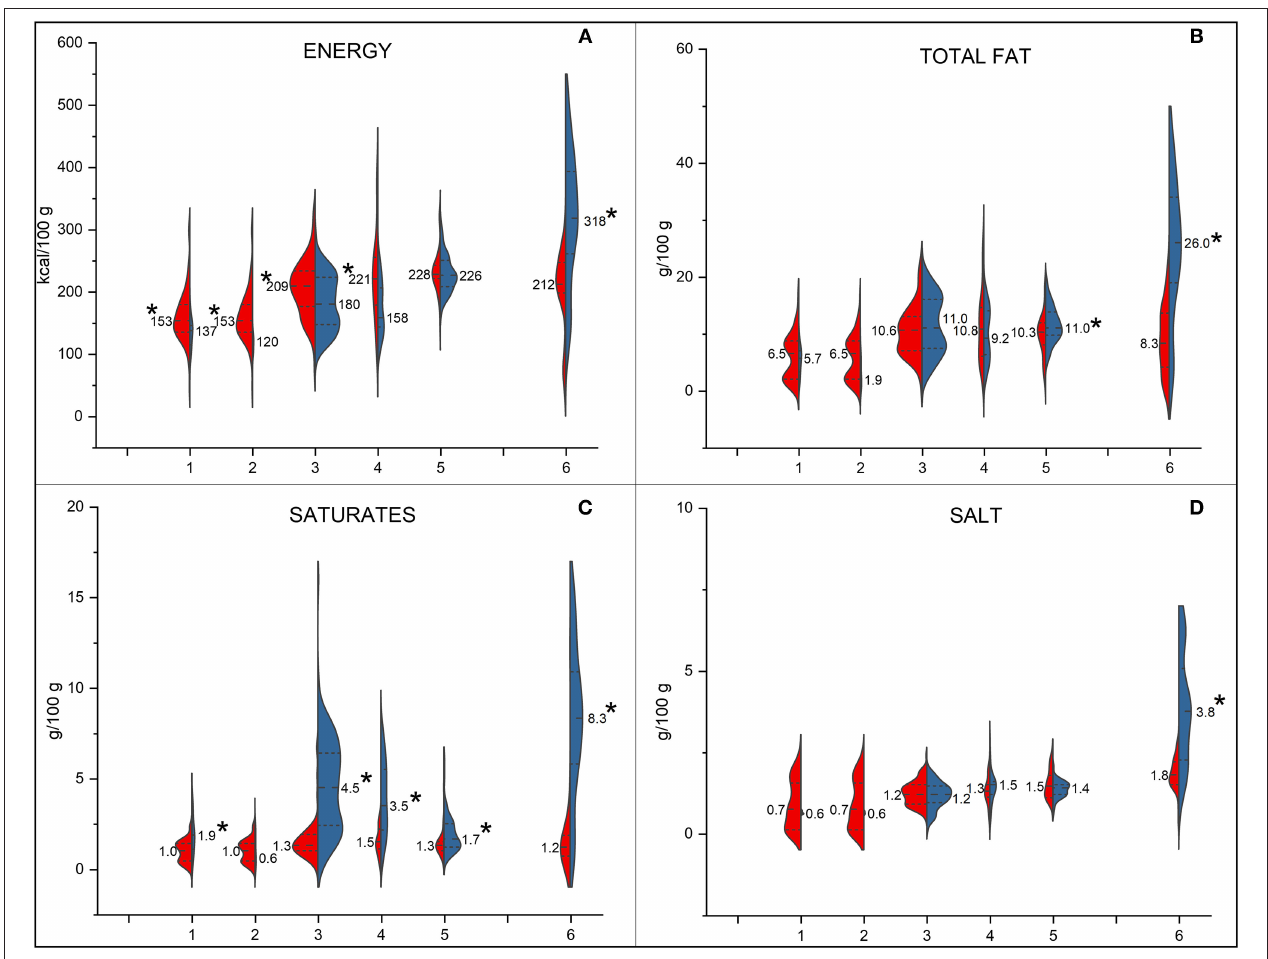
FIGURE 1 | Comparison of nutritional composition—energy (A) , total fat (B) , saturates (C) , and salt (D) —between meat analogue products (in red) and their controls (in blue). In each plot are reported the data of steaks, red meat (1) and white meat (2), burgers (3), meatballs (4), cutlets (5), and cured meats (6). For steaks, 0.5g of added salt per 100g of product was considered. The asterisk refers to differences between commercial products of the same category, for which the Mann–Whitney non-parametric test for two independent samples was used ( p <